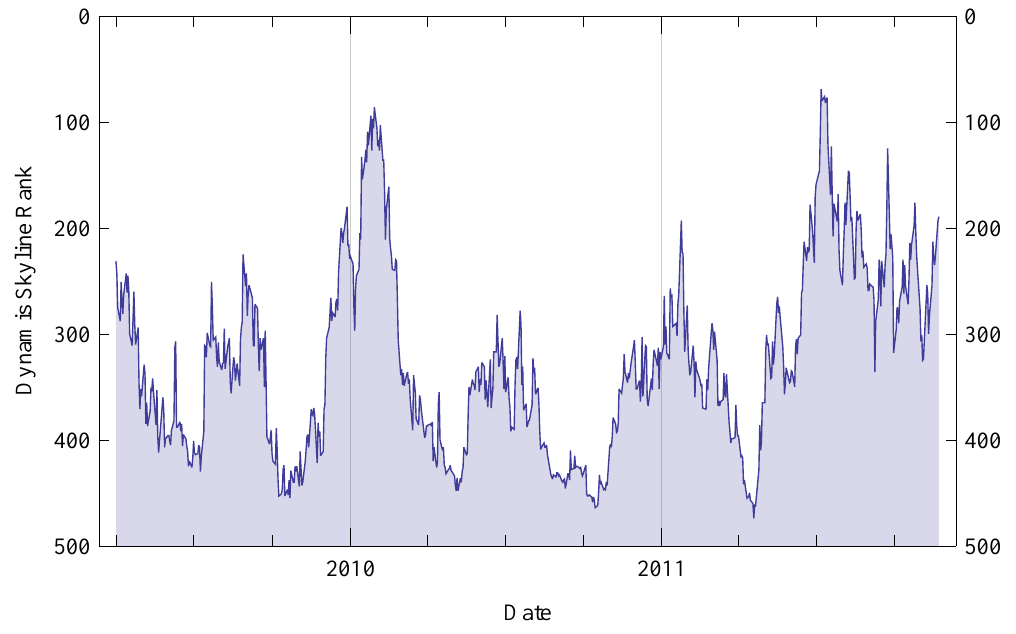
Figure 9. INTC Dynamis skyline rank as its score changes over time in a pool of 500